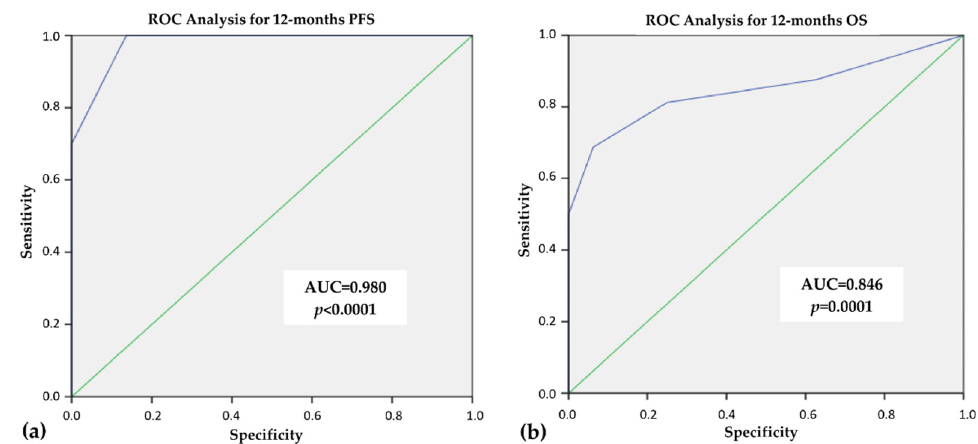
Figure 1. ROC curve analysis for 12-month progression free survival (PFS) ( a ) and 12-month overall survival (OS) ( b ).